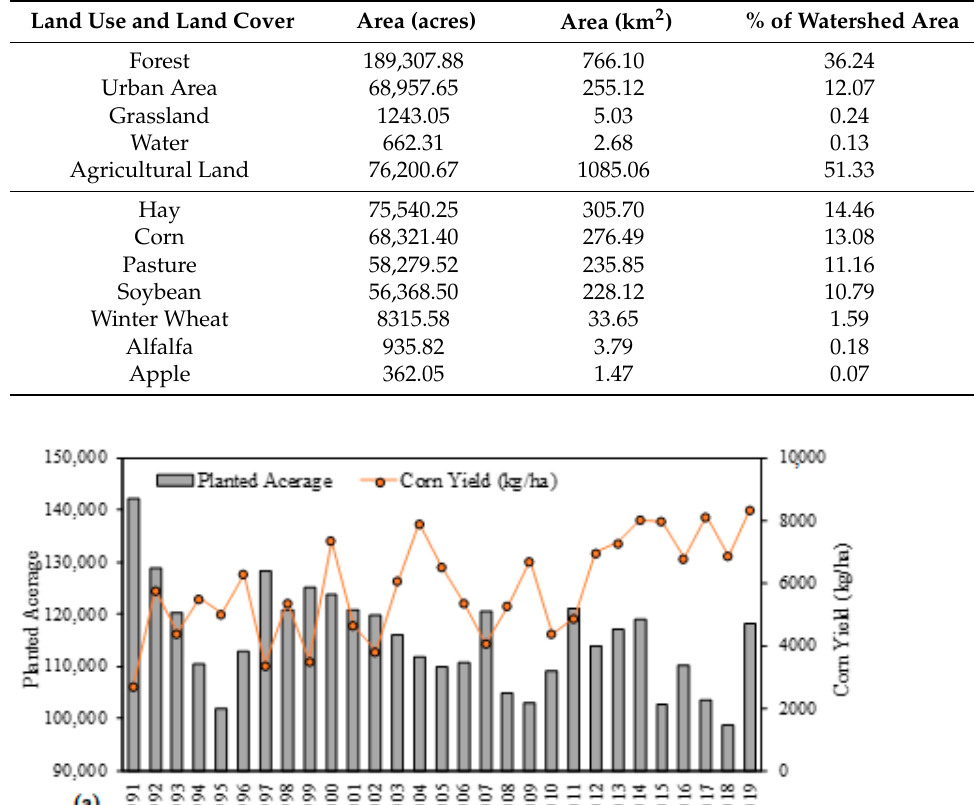
Table 1. Dominant crops and land use.